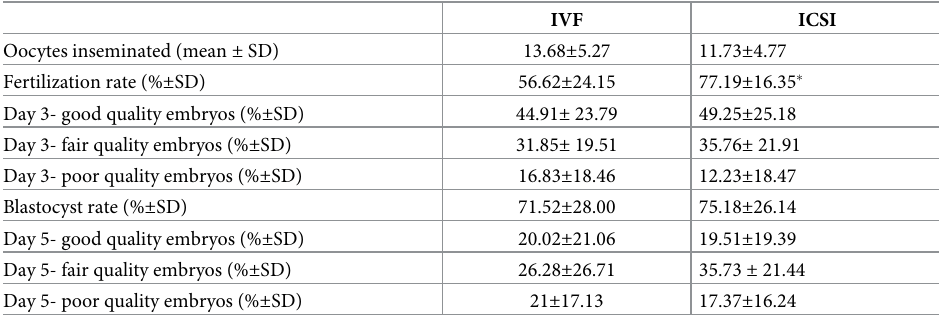
Table 2. Embryological